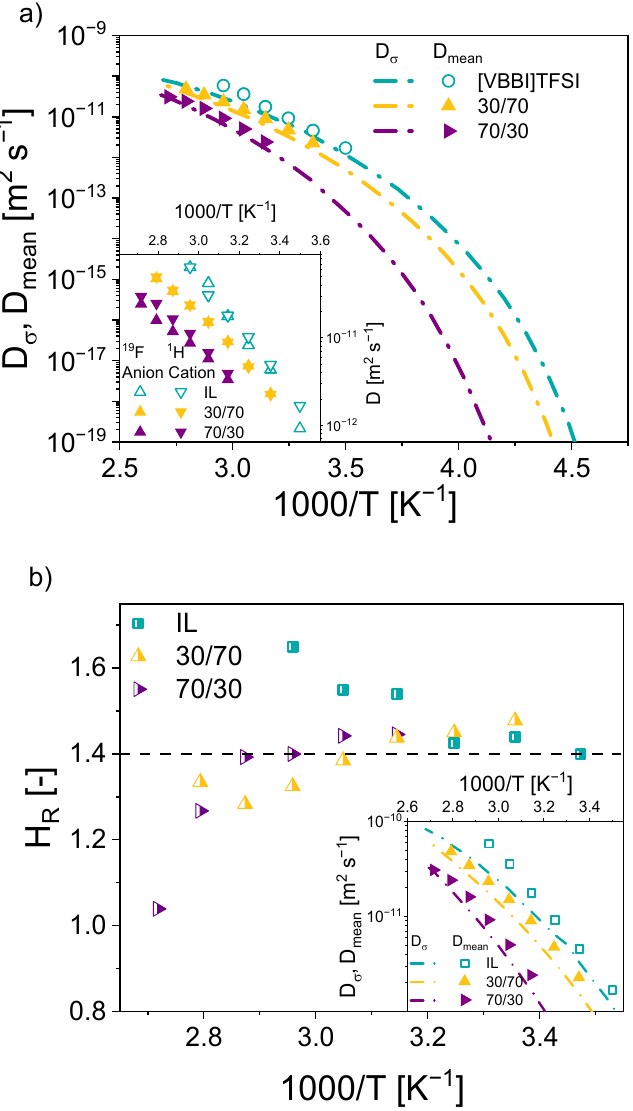
Figure 7. ( a ) Temperature dependence of the mean diffusion coefficients ( D mean ) of the IL, 30 wt% polyIL (30/70), and 70 wt% polyIL (70/30) measured by PFG-NMR. The dashed lines represent the diffusion coefficient calculated from BDS ( D σ ) according to Equation (3). The inset in ( a ) displays the diffusion coefficients of the polycation and anion measured by 1 H and 19 F-PFG-NMR, respectively. ( b ) shows the Haven ratio ( H R ) as a function of the temperature for [VBBI]TFSI, 30 wt% polyIL (30/70), and 70 wt% polyIL (70/30). The Haven ratio ( H R ) is defined as D mean over D σ . The inset in ( b ) furthermore depicts the ratio of D mean over D σ as quantified by H R The temperature dependence of (cid:1830) (cid:3097) follows a VFT form, whereas a clear VFT de ‐ pendence is not observed for the NMR detected (cid:1830) (cid:3040)(cid:3032)(cid:3028)(cid:3041) because the temperature range was limited for experimental reasons. At the same temperature (cid:1830) (cid:3040)(cid:3032)(cid:3028)(cid:3041) (cid:3408) (cid:1830) (cid:3097) , which has